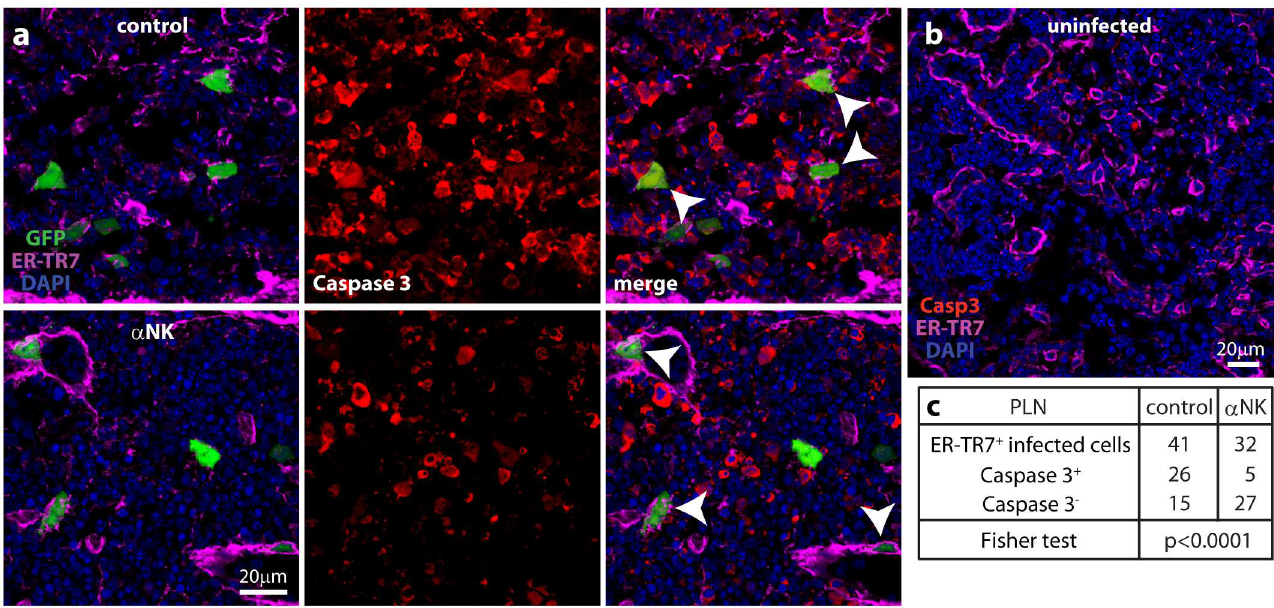
Fig 7. Caspase3 expression in MCMV-infected PLN. (a). C57BL/6mice were depletedof NK1.1 + cells ( α NK) or not (control), then given i.f. MCMV-GR (10 6 p.f.u.). 1 day later PLN sections were stained for viral GFP, the FRC marker ER-TR7 and the apoptotic cell marker caspase 3. Nuclei were stainedwith DAPI. Arrows show exampleFRC, caspase 3 + in the control and caspase 3 - in the α NK. ( b). Stainingof an uninfectedPLN showed negligiblecaspase 3 expression. (c). Countingsamples of mice treated as in a , across 12 sections from 4 PLN, showedby Fisher’s Exact Test a significantreductionin FRC caspase 3 expressionafter α